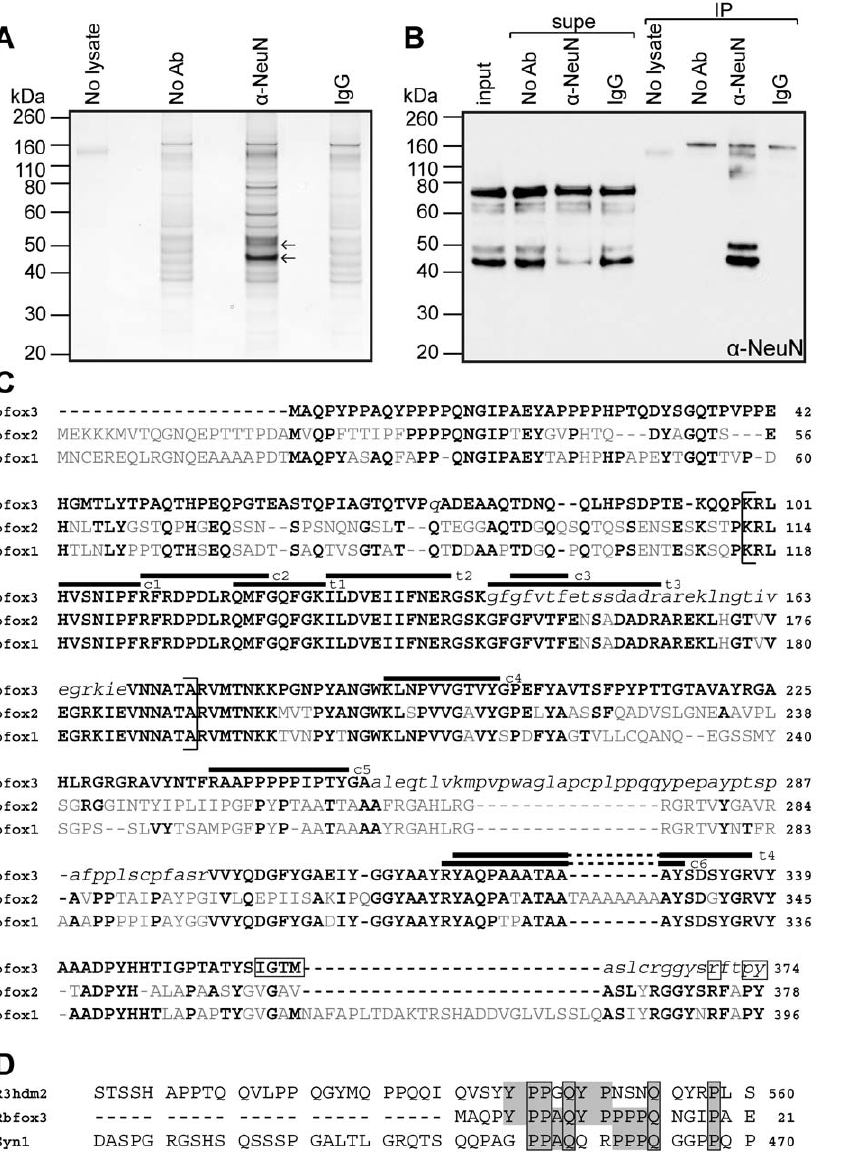
Figure 2. Immunoprecipitation and mass spectrometry identify Rbfox3 as the target of anti-NeuN. A. Silver stain of proteins immunoprecipitated from P20 mouse brain crude nuclear extract using anti-NeuN, and separated by non-reducing SDS-PAGE. No antibody, ands mouse IgG were used as IP controls; the no lysate sample was used to check the integrity of anti-NeuN cross-linking (covalent coupling) to the beads. Arrows point to the bands analyzed by mass spectrometry. B. Western confirms the specificity of the anti-NeuN immunoprecipitation. The ‘‘classic’’ NeuN doublet species below 50 kDa were efficiently immunoprecipitated, and depleted from the supernatant (supe), while the upper immunoreactive bands were not. C. Alignment of the mouse Fox protein family. Accession numbers of the sequences shown are; Rbfox1 (Fox-1, A2bp1, Hrnbp1) NP_067452, Rbfox2 (Fox-2, Rbm9, Fxh) NP_001104299, Rbfox3 (Fox-3, Hrnbp3) NP_001034256. Amino acids that differ in sequence from Rbfox3 are shown in grey. Lower case italics denote regions of Rbfox3 that may be absent due to alternative splicing. The RRM domain (as defined by UniProt) is contained within parentheses. Black lines above the sequence mark peptides identified by MS after in-gel digestion with chymotrypsin (c) or trypsin (t). Boxes surround Rbfox3 residues that match the hPY-NLS consensus. D. Alignment of the anti-NeuN ABS from R3hdm2 with the N-terminus of Rbfox3 and the predicted antibody-binding region of Syn1 from Kim et al. [5]. Amino acids identical to those in Rbfox3 are shaded grey, boxes outline amino acids that are identical across all three proteins.